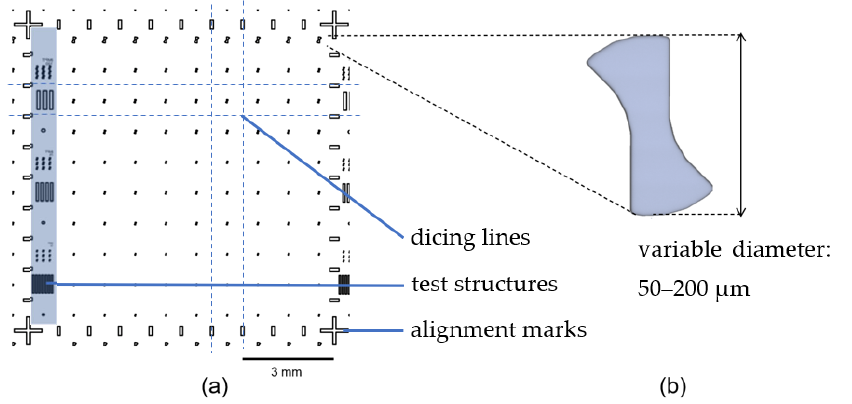
Figure 2. Concept of the mask: ( a ) an excerpt of 10 × 10 mm 2 of the mask concept and ( b ) detailed image of the milling geometry with various diameters.